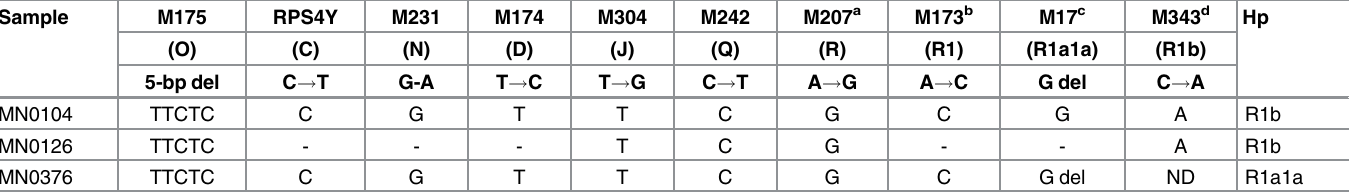
Table 2. Y-haplogroups of the male Tavan Tolgoi